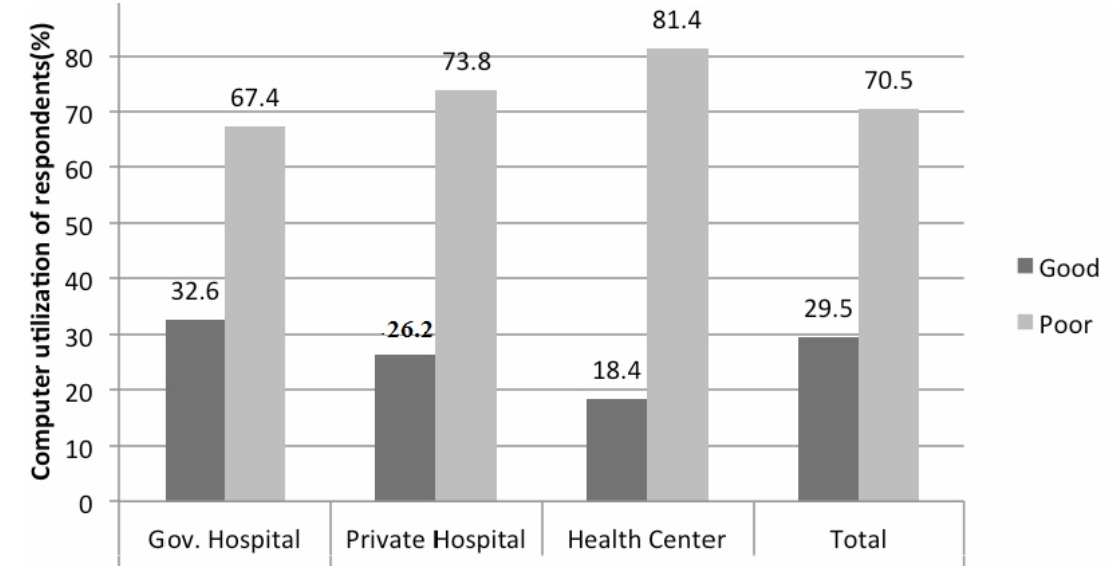
Figure 2. Utilization of computers among health